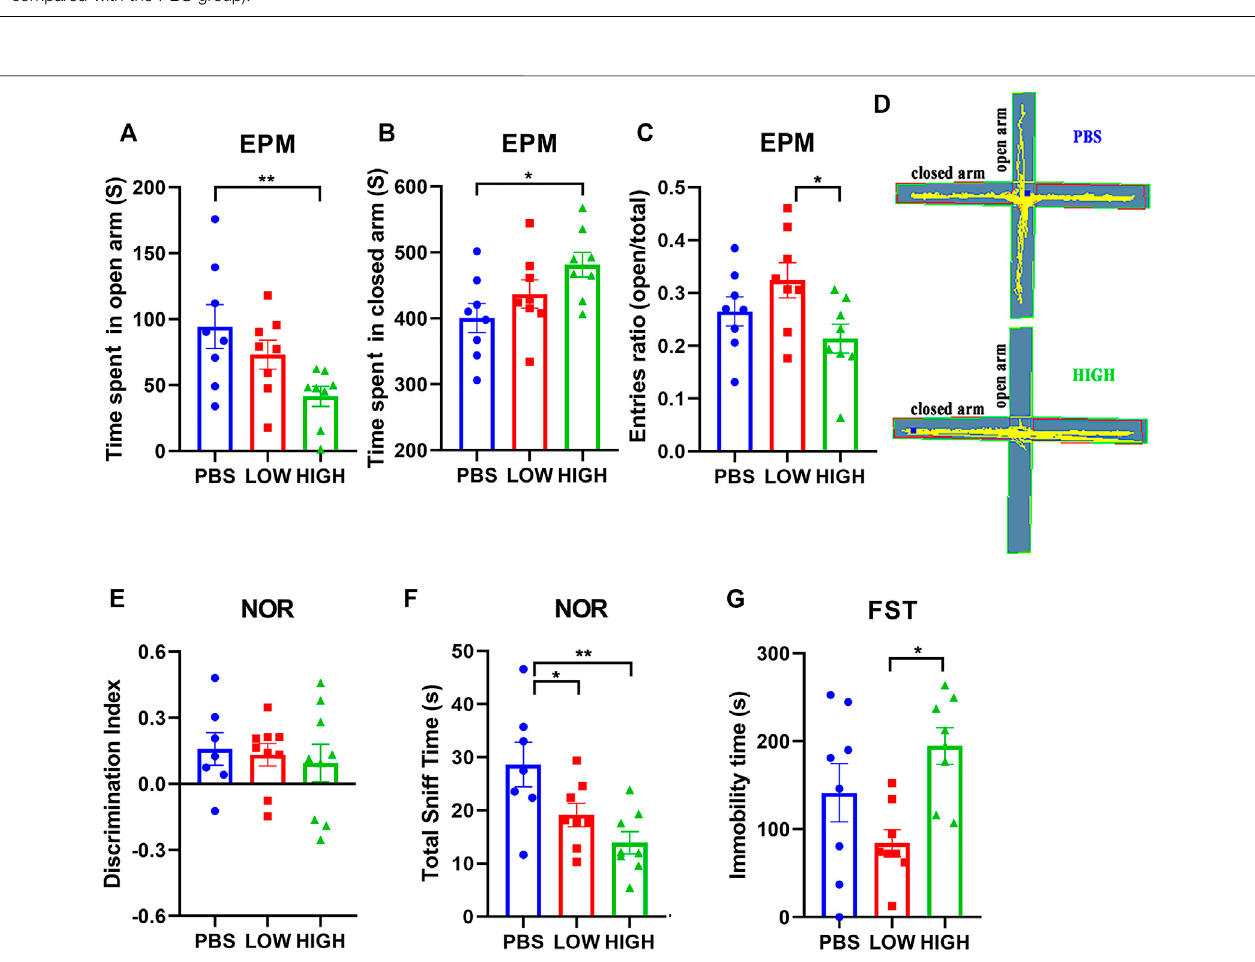
FIGURE2| EffectsofHCQonthebehaviorsofmiceintheimmediategroup. (A – C) Elevatedplus-mazetest. (A) Timespentintheopenarms. (B) Timespentinthe closed arms. (C) Entries ratio (entries to open arms/(open arms + closed arms). (D) Typical trajectory of mice in the high-dose group and PBS group. (E,F) The novel object recognition test. (E) The discrimination index ((novel − familiar)/(novel + familiar)). (F) The total time spent snif fi ng. (G) The immobility time in the forced swim test ( n (cid:1) 8 for each subgroup in EPM and FST; n (cid:1) 7 − 8 for each subgroup in NOR; one-way ANOVA; * p < 0.05, ** p < 0.01).